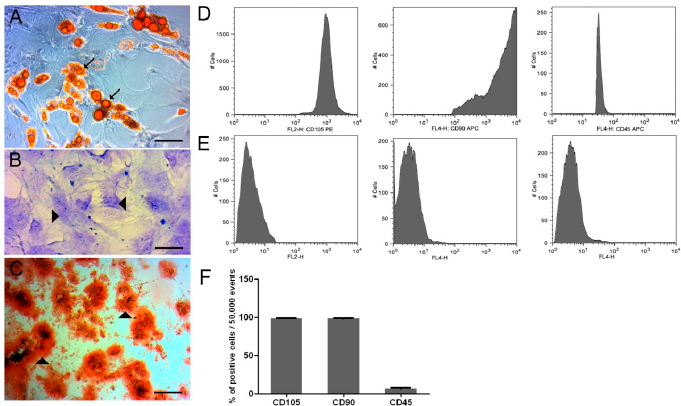
Figure 1. In vitro adipogenic ( A ), condrogenic ( B ), and osteogenic ( C ) differentiation of adipose-derived mesenchymal stem cells (ADMSC) in 5P: Observe intracellular lipid droplets stained with Sudan IV ( → ), proteoglycans stained with toluidine blue ( (cid:73) ), and extracellular calcium stained with alizarin red S ( (cid:73) ). Bars = A and C: 200 µ m; B: 100 µ m. ( D ) Histograms demonstrate the x-axis fluorescence scale considered positive when the cell peak is above 10 1 (CD45) or 10 2 (CD105 and CD90). ( E ) Control for –PE and –APC (with very low fluorescence), corresponding to non-marked cells. ( F ) Flow cytometry of ADMSC for CD105, CD90, and CD45 surface